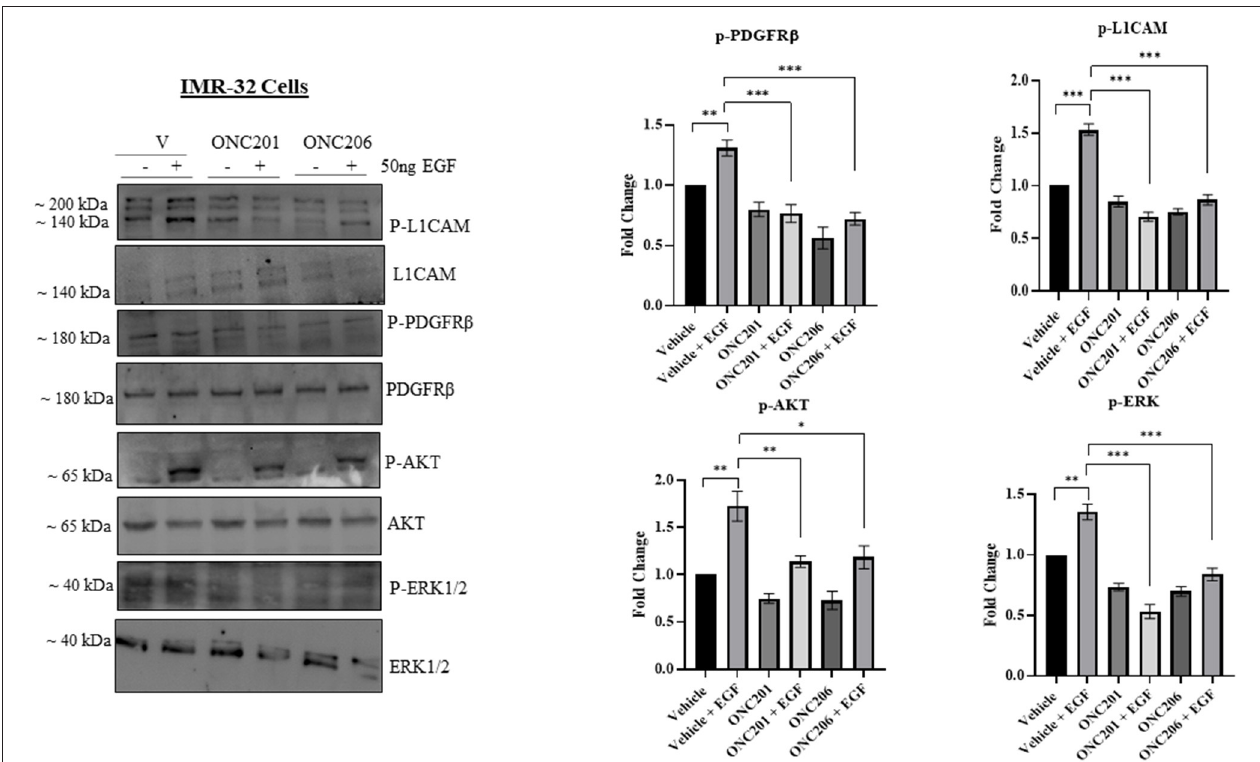
FIGURE 9 | ONC201/ONC206 treatment induces differential expression of tumorigenic proteins in IMR-32 cells. EGF-induced phosphorylation of L1-CAM, PDGFR β , and AKT/ERK was significantly reduced with a single continuous dose of either ONC201 (5 µ M) or ONC206 (0.5 µ M) treatment compared with vehicle-treated cells. Experiments were conducted in triplicates and repeated three times. Data represent the mean ± the standard error of the mean (SEM) of multiple experiments. * p < 0.05; ** p < 0.01; *** p < 0.001.